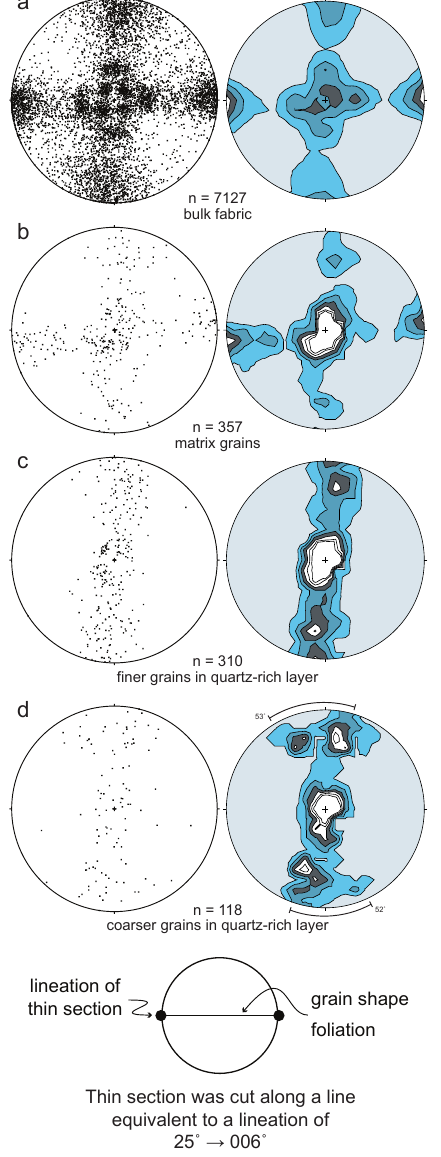
Figure 4. Quartz crystallographic fabrics from various quartz pop- ulations in the specimen. All diagrams are lower hemispherical equal area stereonet projections contoured at 1% intervals. Con- tours for (a) are 1, 2, 3, 4 times uniform; for (b) through (d) they are 1, 2, 3, 4, 5, 6 + times uniform. The stereonets are oriented such that the foliation forms a vertical plane, while the observed lineation (and orientation of thin section) follows a horizontal E–W line. (a) Combined/bulk crystallographic fabric generated from an 8000-point grid mapped across the specimen. (b) Quartz crystallo- graphic fabric generated from manually selected matrix grains. (c) Crystallographic fabric of the finer-sized quartz population within the quartz-rich lens. (d) Crystallographic fabric of the coarser-sized quartz population within the quartz-rich